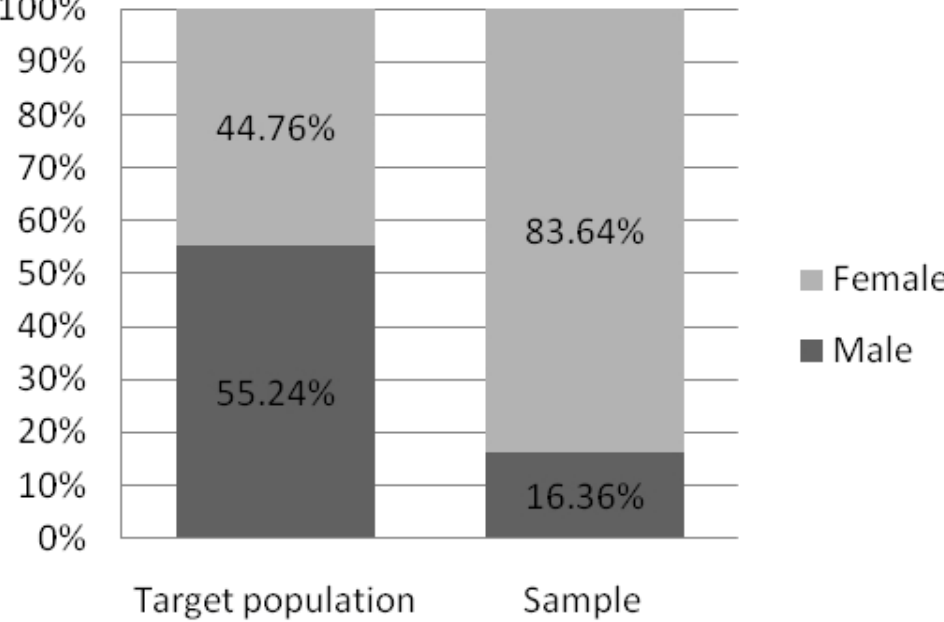
Figure 7. Sex distribution in the target population and the study sample (based on Statistic Poland). Note: Status report on target Polish working population in the 4th quarter of 2020 according to “Yearbook of Labour Statistics 2021”; Statistics Poland.